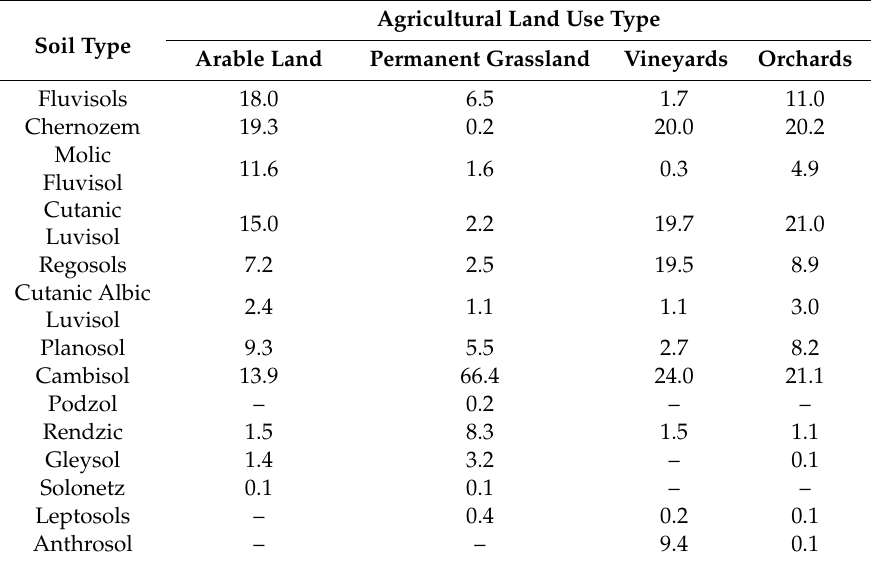
Table 4. Share of soil type (%) in agricultural land use types in